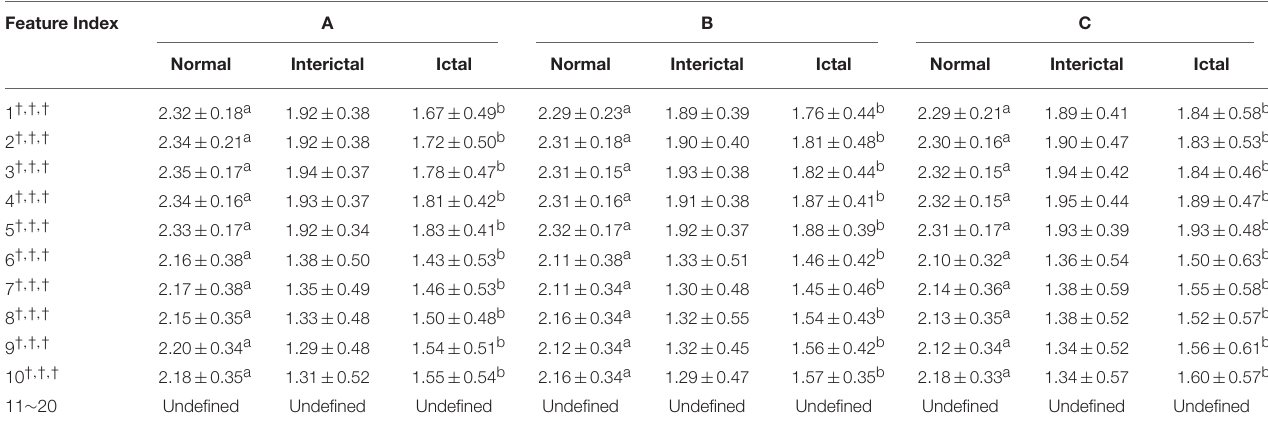
TABLE 2 | SampEn of normal, interictal, and ictal EEG recordings. Feature Index